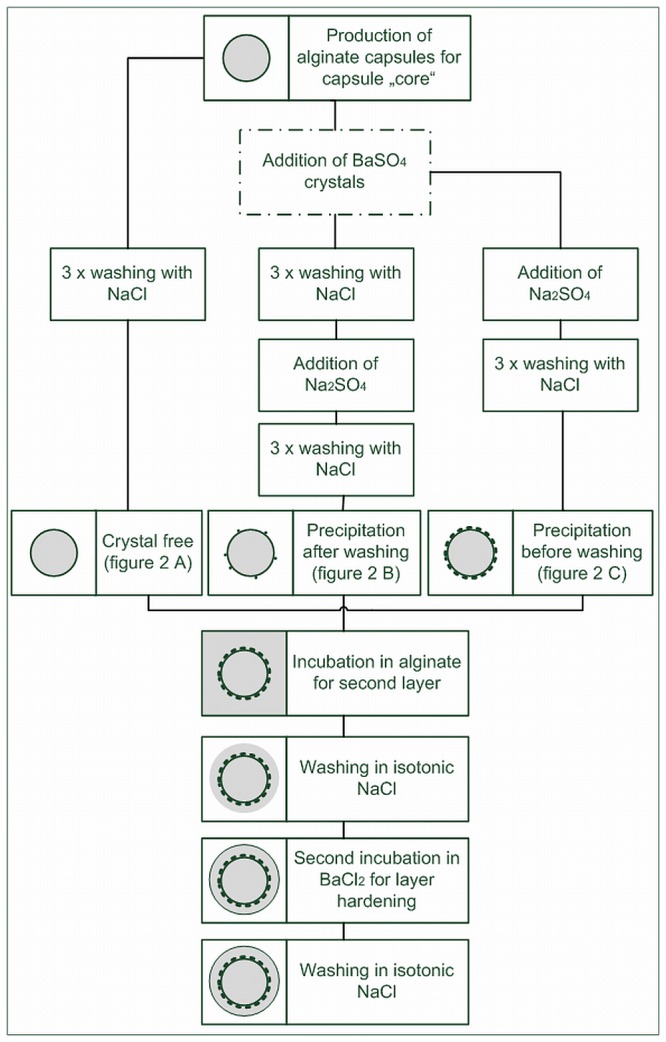
Flow chart for production of alginate bilayers with and without BaSO4 crystals.